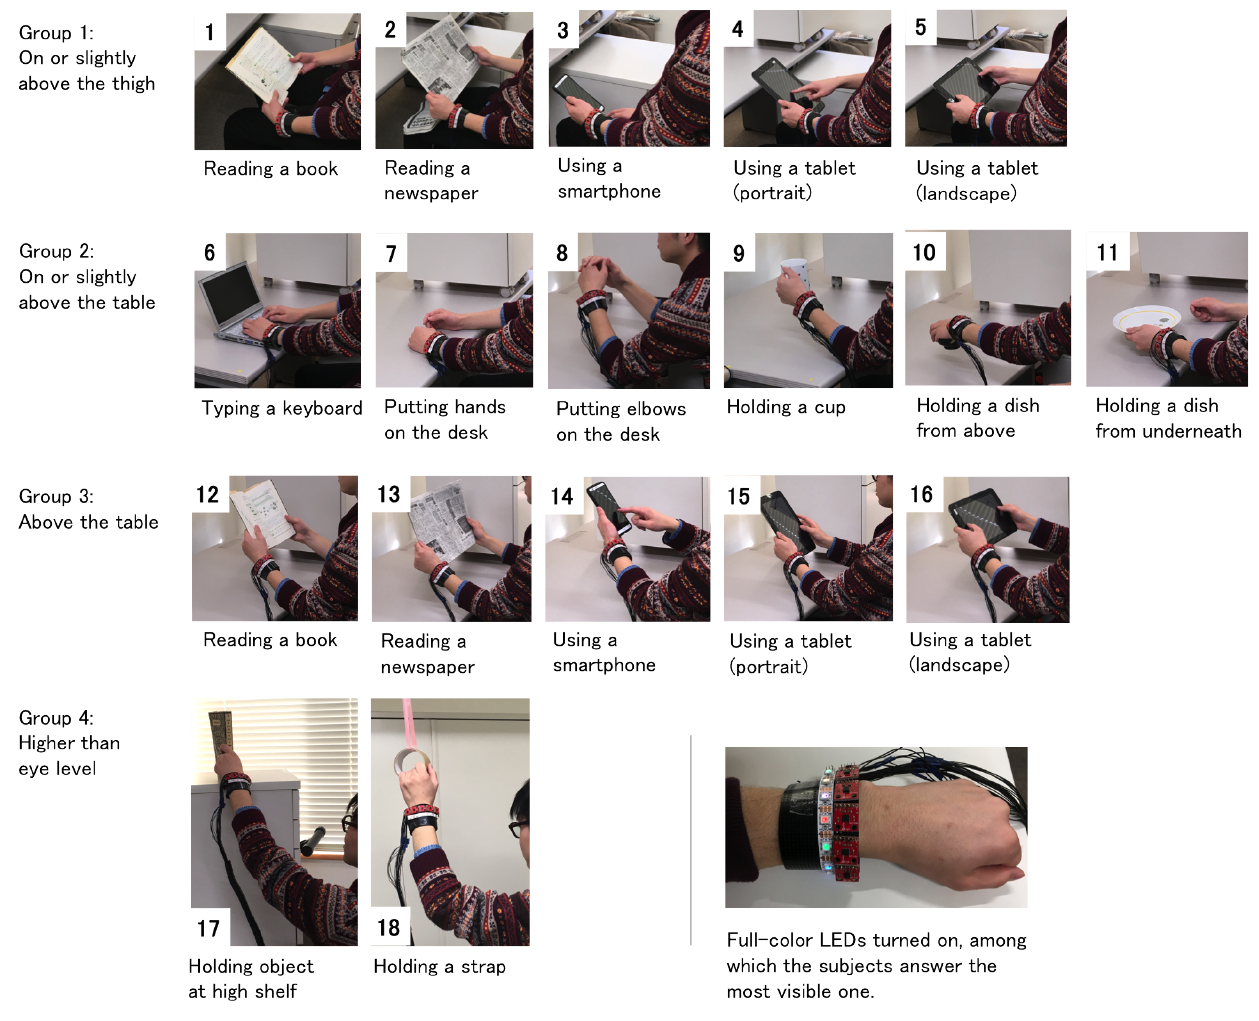
Figure 3. Forearm postures in data